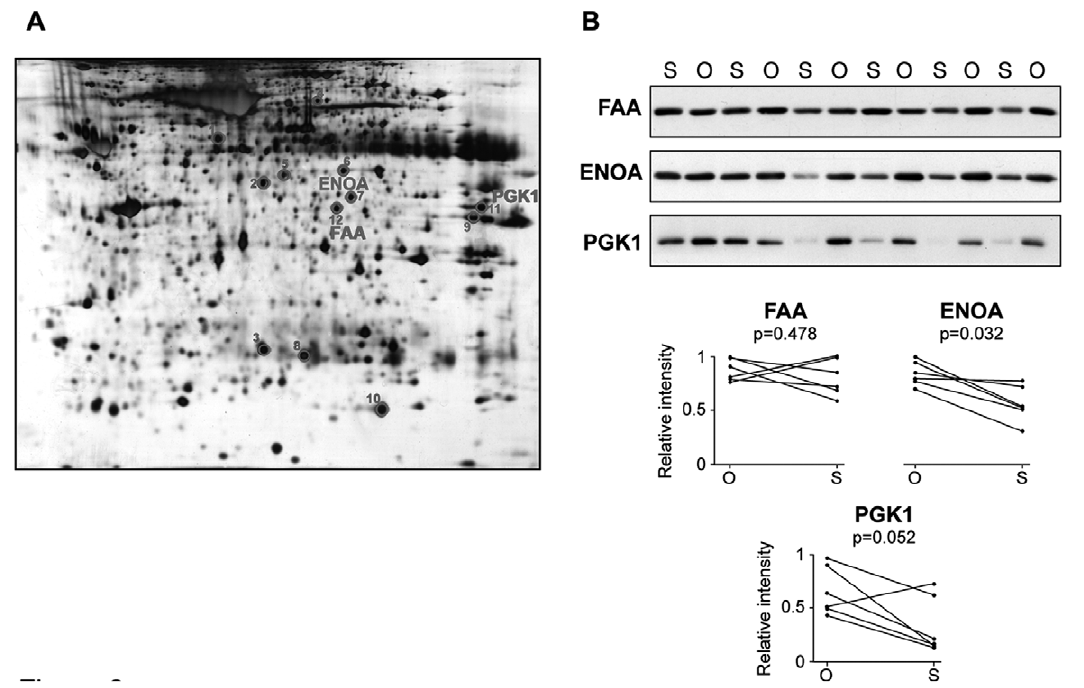
Figure 2. Proteins identified by 2D-DIGE and MS showing sustained expression levels in omental and subcutaneous adipose tissues. Protein extracts from subcutaneous and omental adipose tissue paired samples were analyzed by 2D-DIGE [10]. Proteins were revealed by AgNO 3 staining and based on DeCyder analysis the spots of interest were excised from the gel and subject to MS-based identification. A representative silver-stained gel is shown; the numbers correspond to 12 selected protein spots as indicated in Table 1 (A). Representative Western Blot analysis of selected proteins in omental (O) and subcutaneous (S) fat samples. Paired relative intensity values from band densitometry in fat samples from the same individual are represented (B).